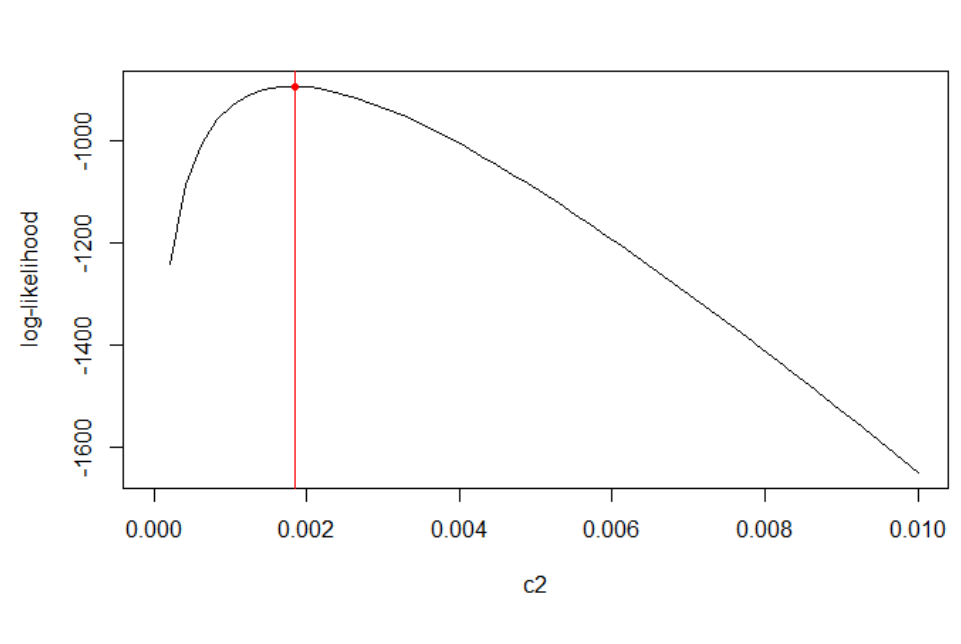
Figure 15: Output of conductance surface with telemetry